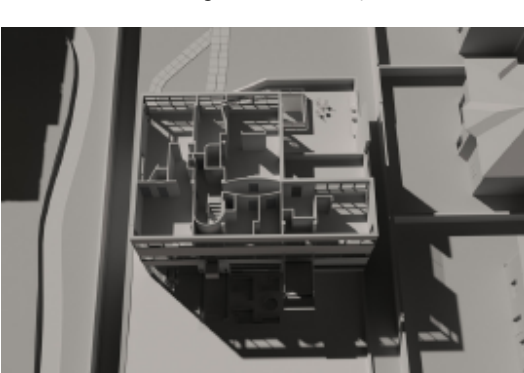
Figure 13. North façade